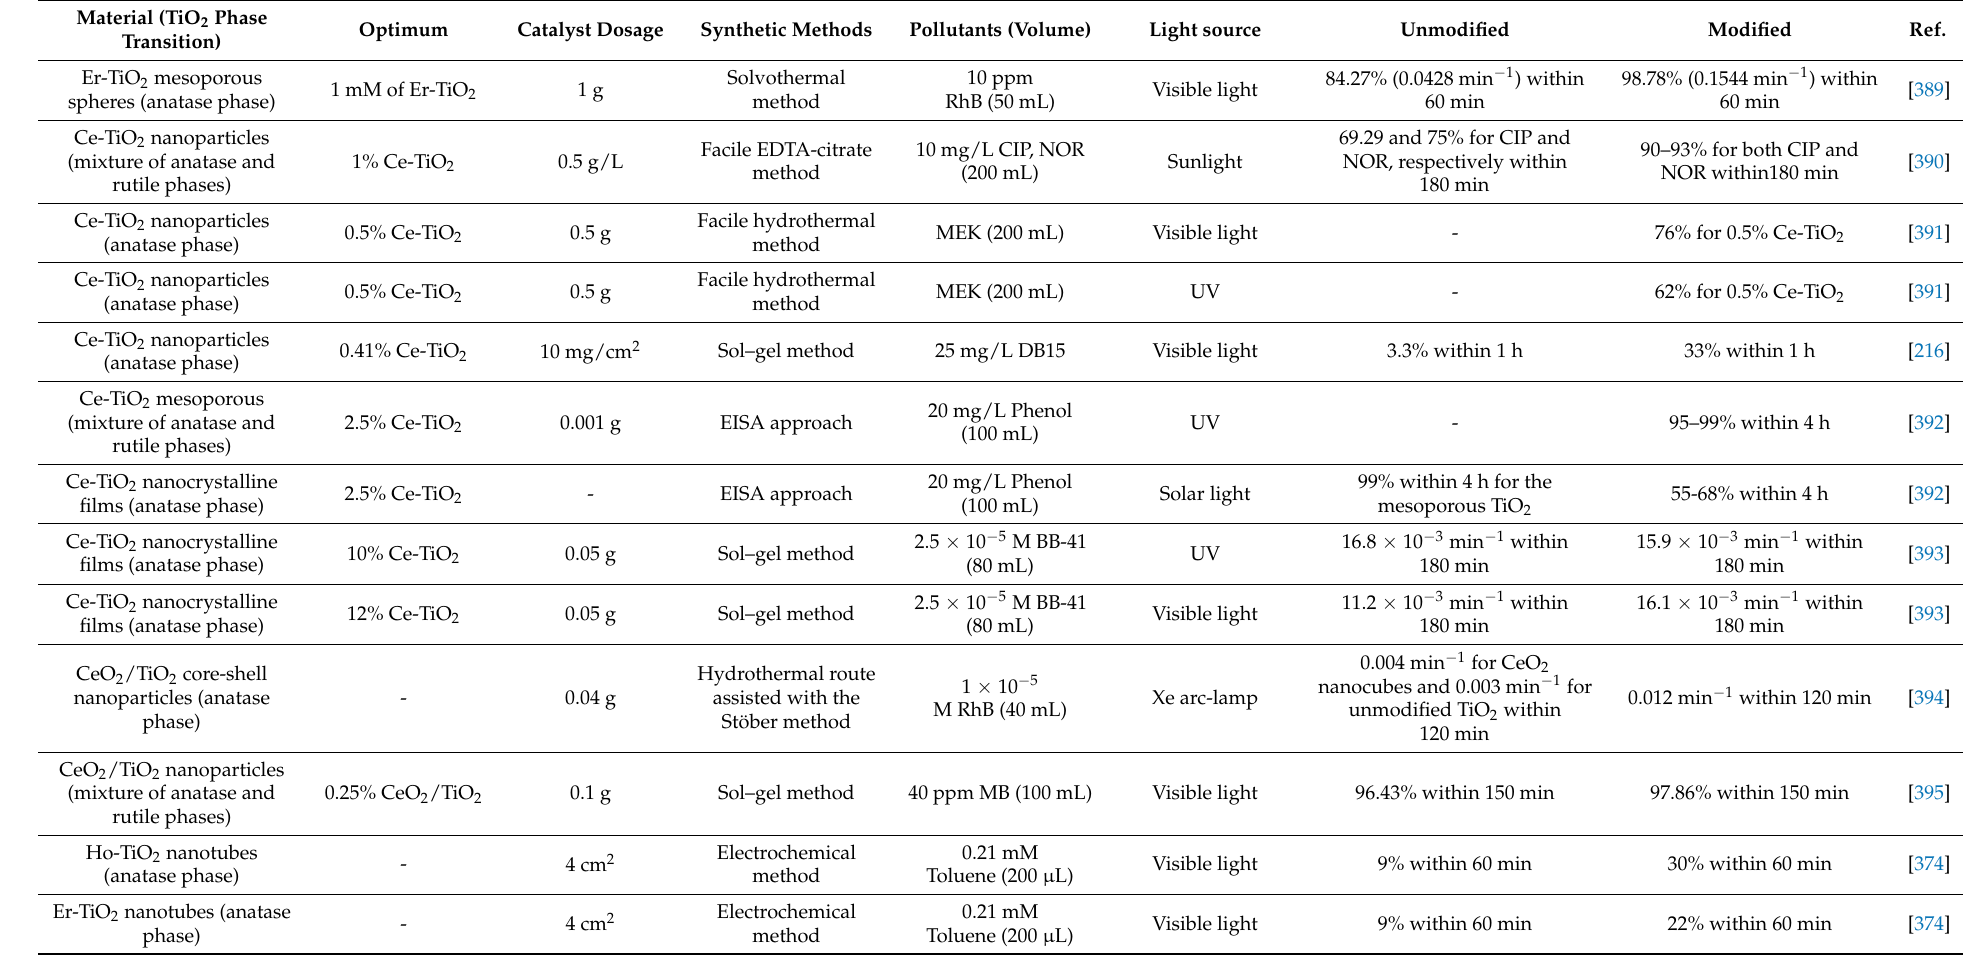
Table 21. Summary of recent progress on lanthanides modified TiO 2 photocatalysts for organic pollutants